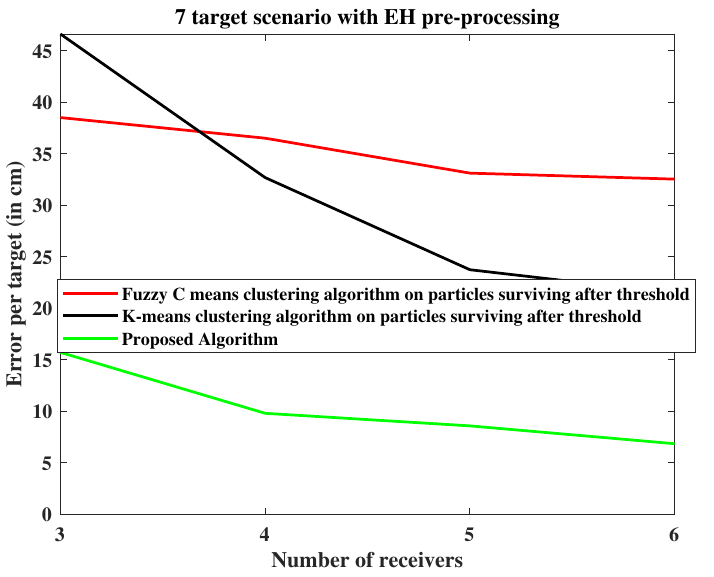
Figure 12. Performance comparison with different number of receivers for σ = 0.1 and number of intermediate locations, M = 7.